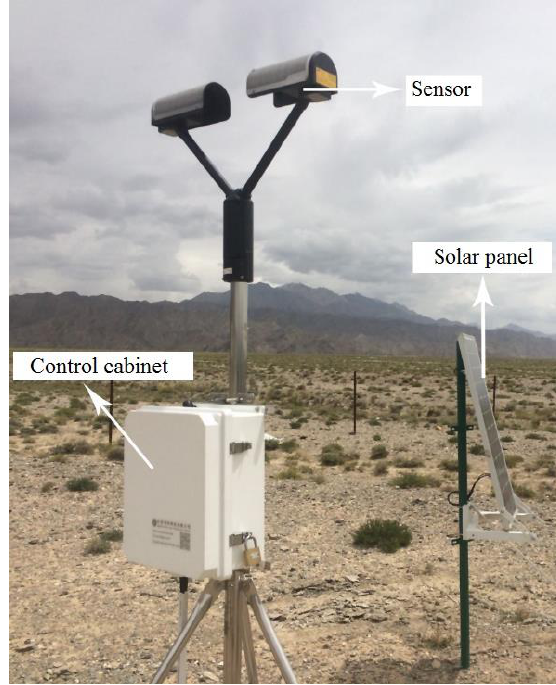
Figure 2. The OTT Parsivel 2 laser raindrop spectrometer.